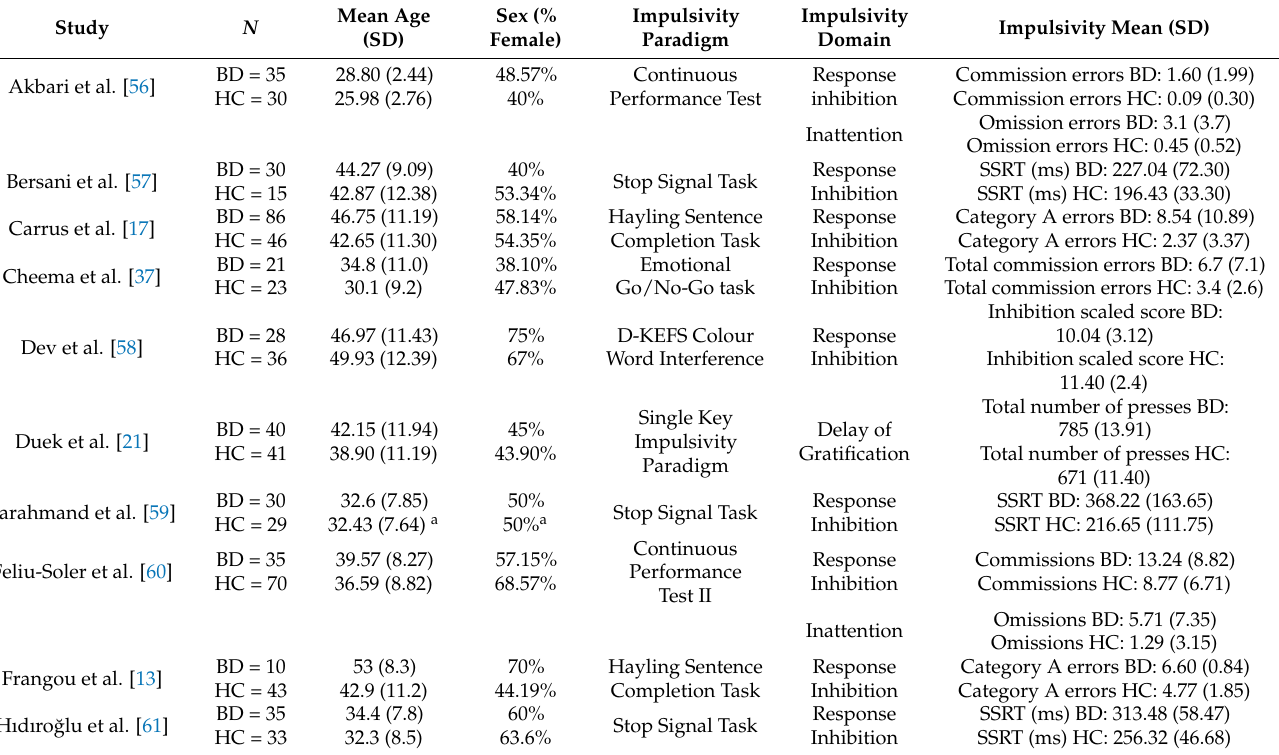
Table 2. Study characteristics of behavioural impulsivity